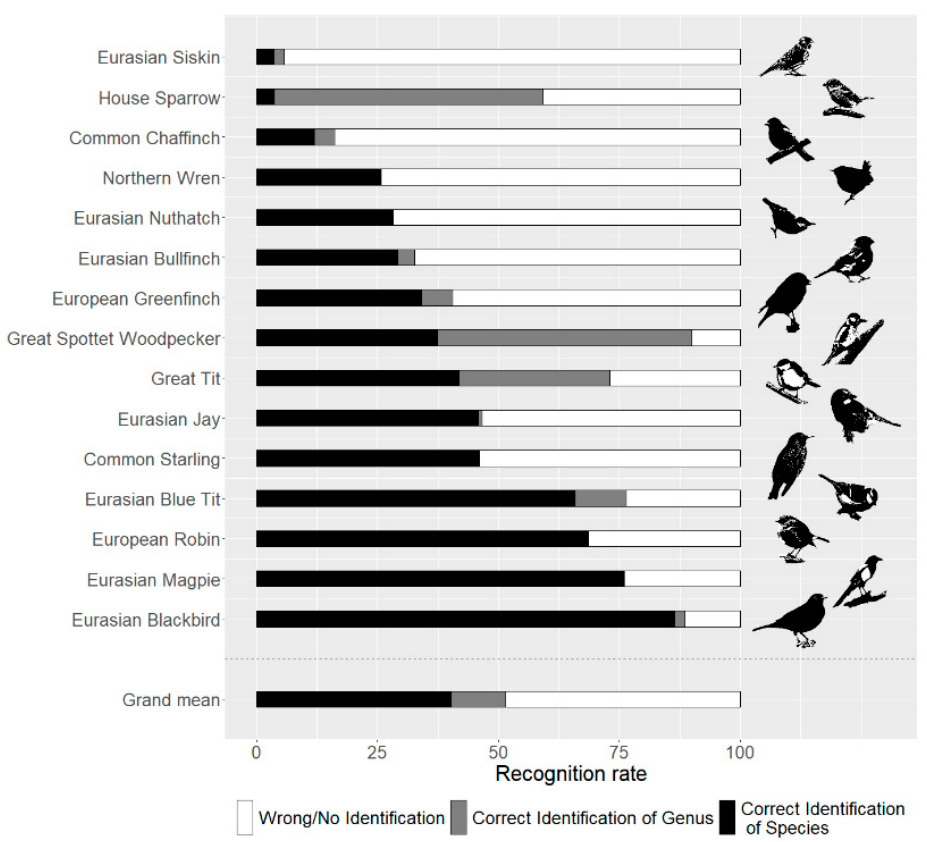
Figure 4. Species sorted by their recognition rates on species level. Table 3. Recognition rates within the group of pupils and adults in comparison with the frequency of occurrence in gardens measured as the number of observations during the Citizen Science projects winter bird count 2021 and garden bird count 2020. Data from